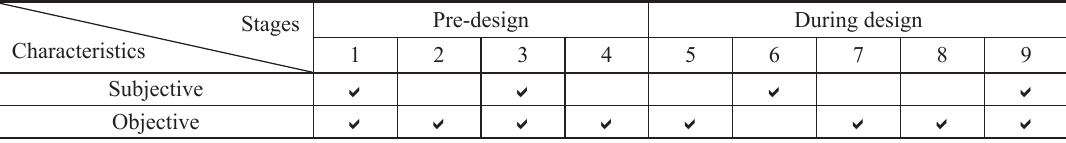
Table 7. Characteristics of difficulty